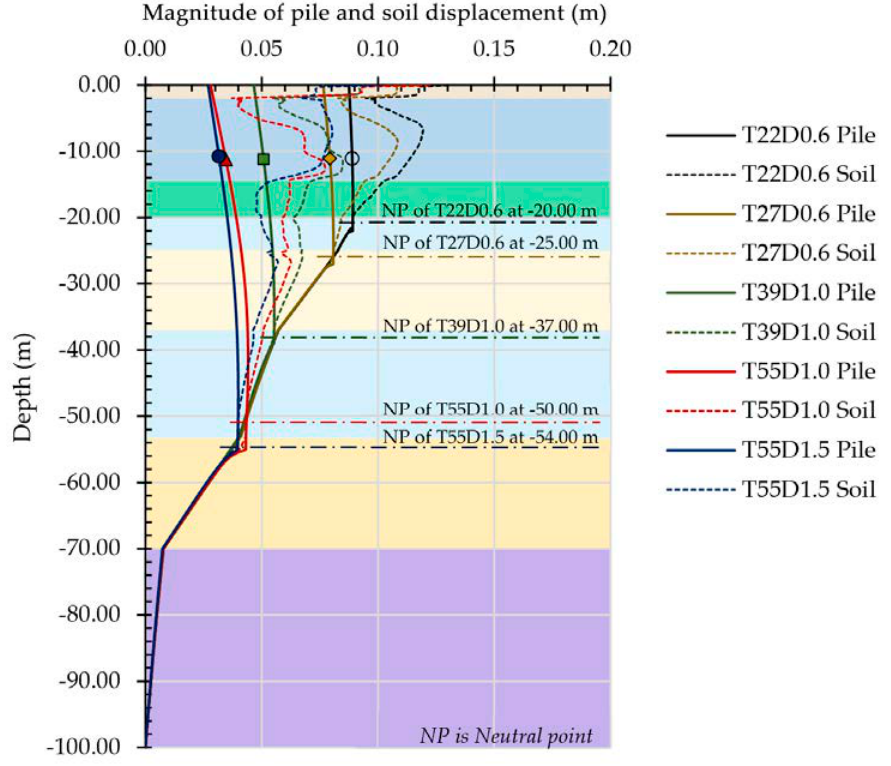
Figure 10. Magnitude of pile and soil displacement along the vertical axis.